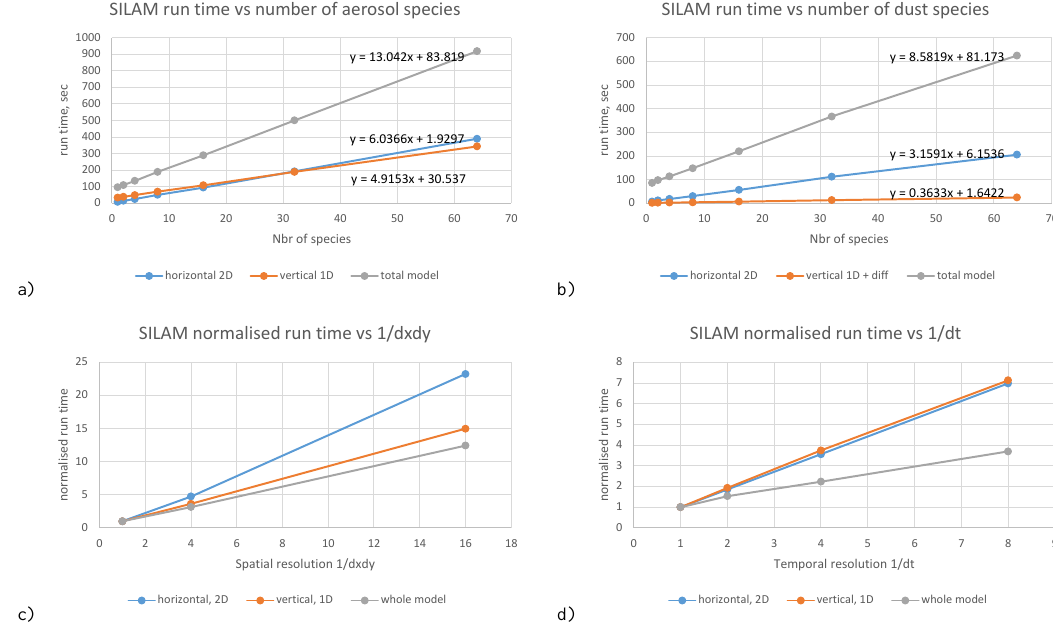
Figure 16. Scalability of the Galperin advection scheme and the SILAM model. Panel (a) Full-grid run time for different numbers of species, (b) sparse-plume run time for different numbers of species, (c) full-grid run time for varying horizontal grid resolutions, and (d) full-grid run time for varying time